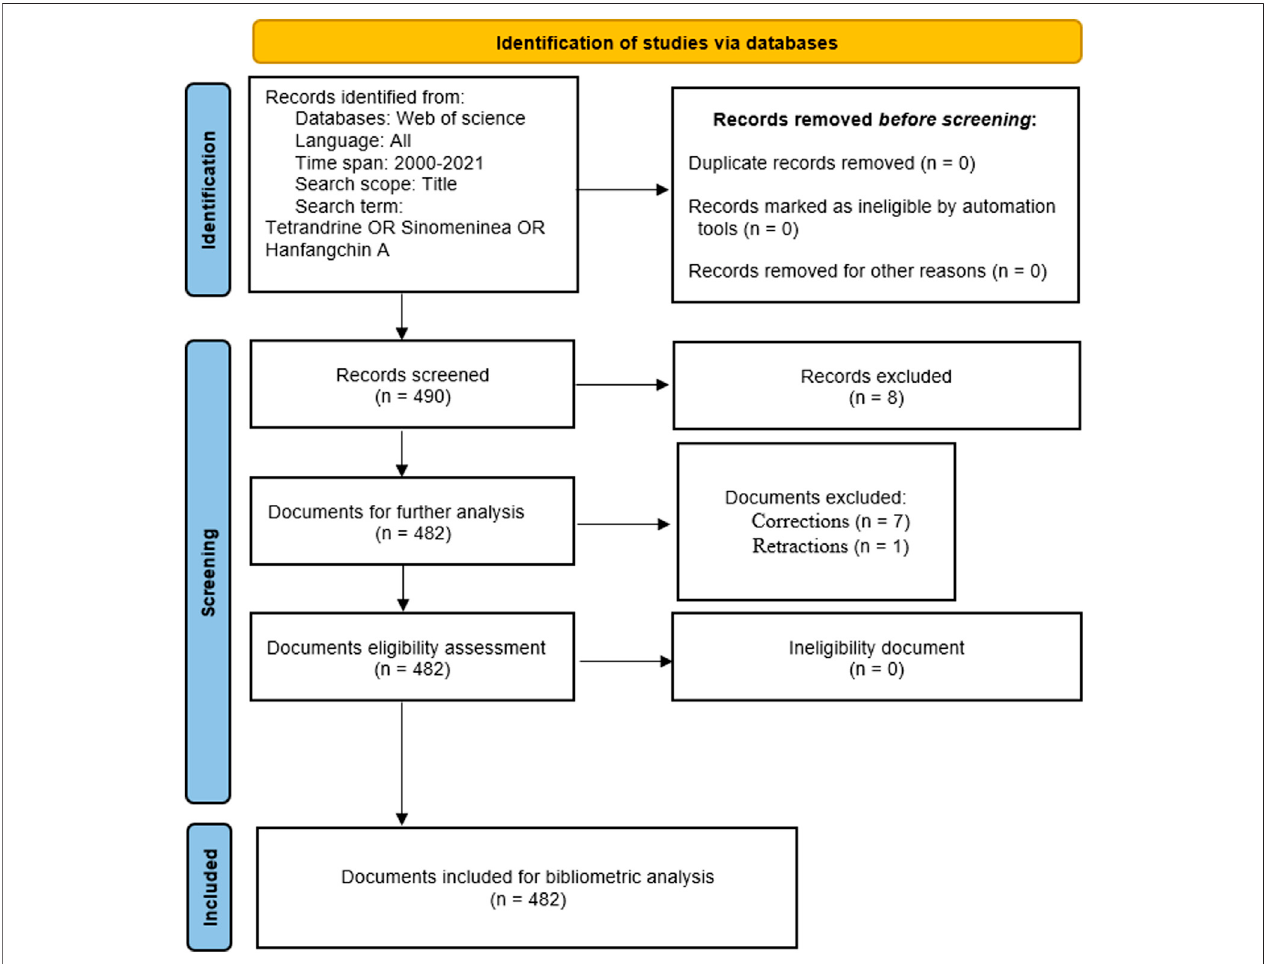
FIGURE 1 | Flow diagram of the search